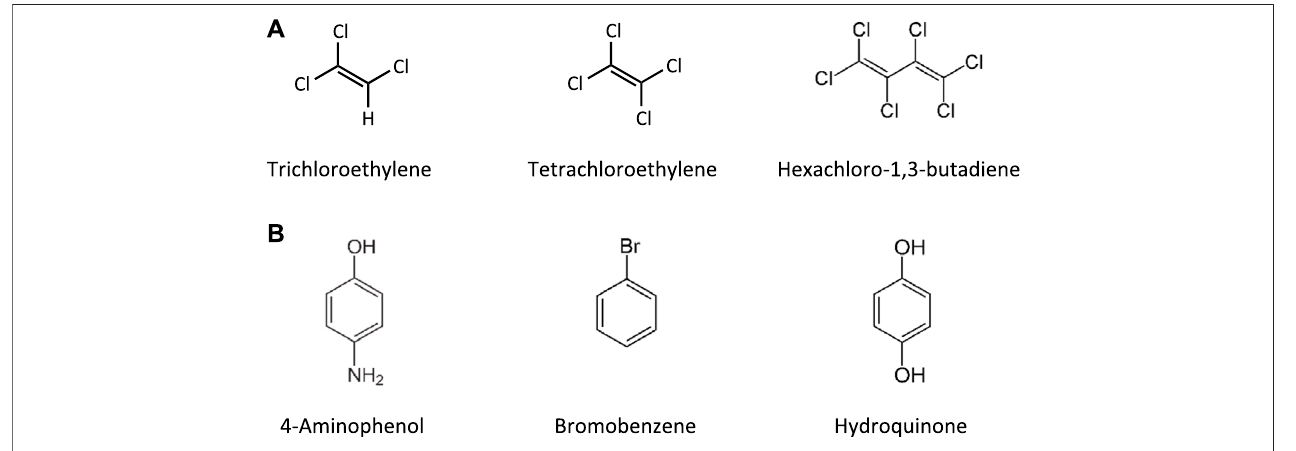
FIGURE6| Chemicalstructuresofnephrotoxichaloalkenes (A) and phenols and heteroatom-substituted benzene derivatives thatare bioactivated tonephrotoxic quinones (B) .